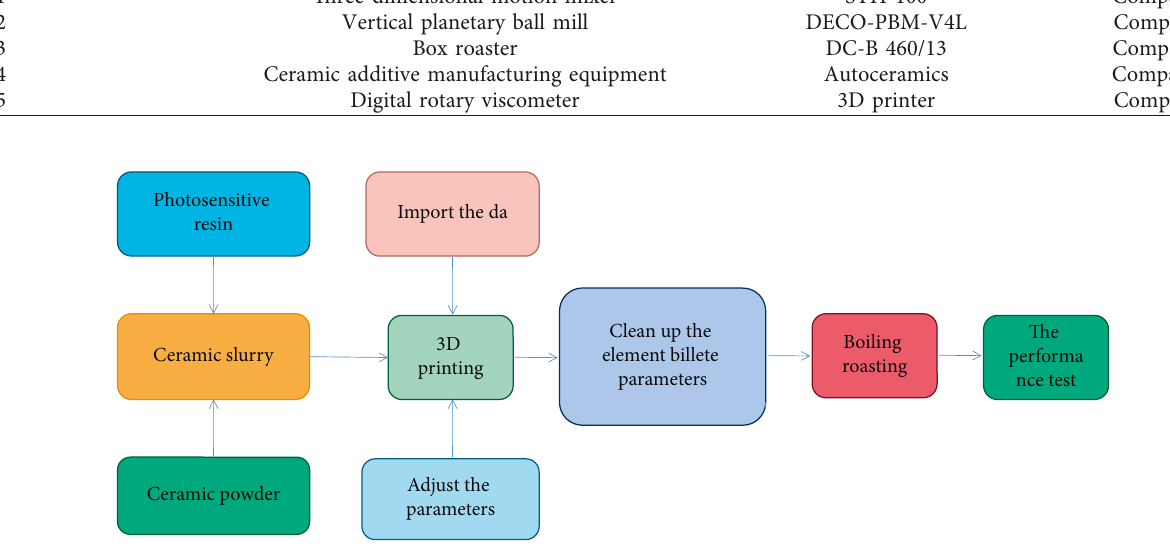
Figure 2: Process diagram of 3D printing ceramic core.